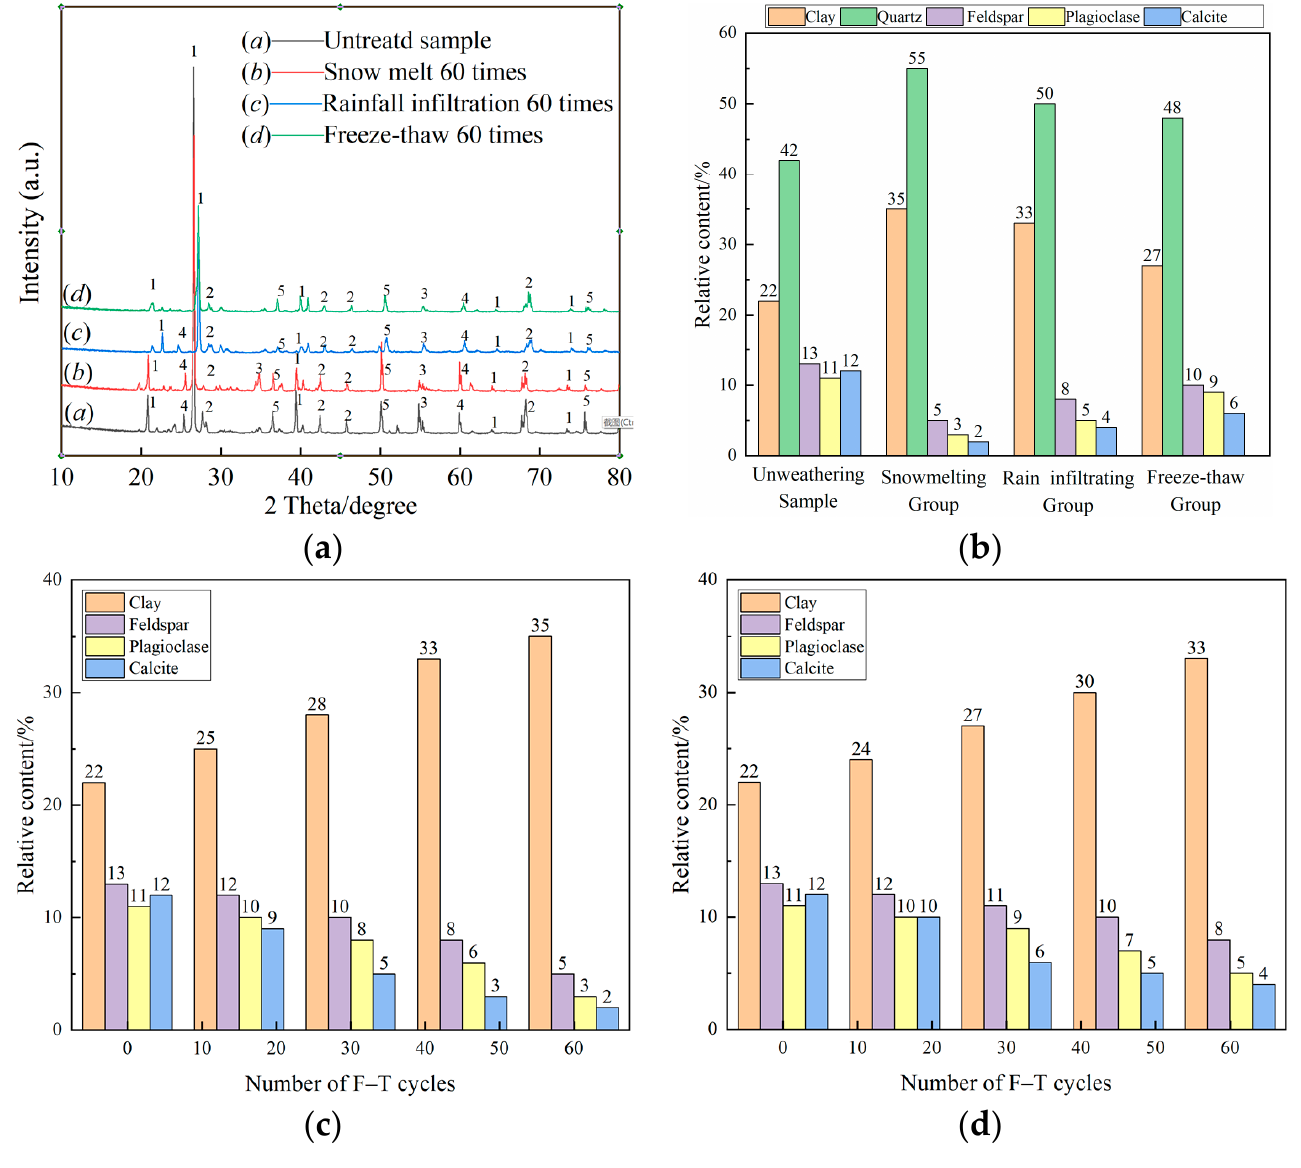
Figure 8. X-ray diffraction (XRD) scans of rock for three F–T cycle treatments. ( a ) XRD spectrogram (1—quartz, 2—clay, 3—feldspar, 4—plagioclase, 5—calcite). ( b ) Mineral content variation after three F–T cycle treatments. ( c ) Mineral content variation in snowmelt group. ( d ) Mineral content variation in rain infiltration group.